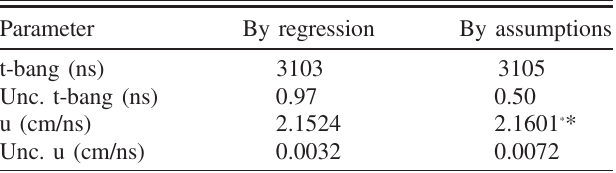
TABLE IV. A comparison of parameter values and uncertain- ties by the regression analysis of Eq. (4) with corresponding values obtained under the a priori assumptions that uncertainties are δ L ∼ 1 cm and δ t ∼ 1 ns, respectively; the formulas are given in the text. Parameter By regression By